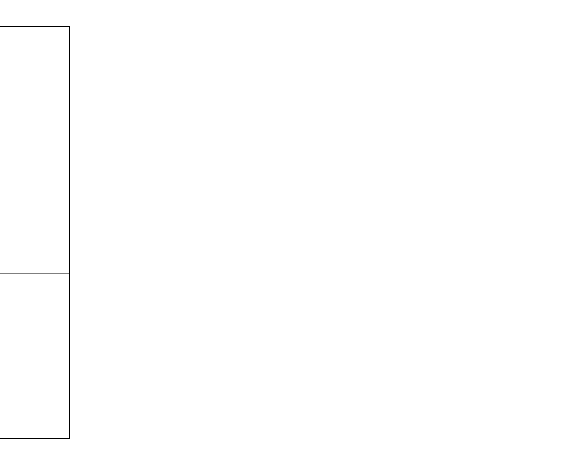
Figure 4. A sample pattern of segregation. The white and black cells are where the minority population comprises 0% and 100% of the local population, respectively. The numbers inside of the cells indicate the cell ID, and the letters denote the